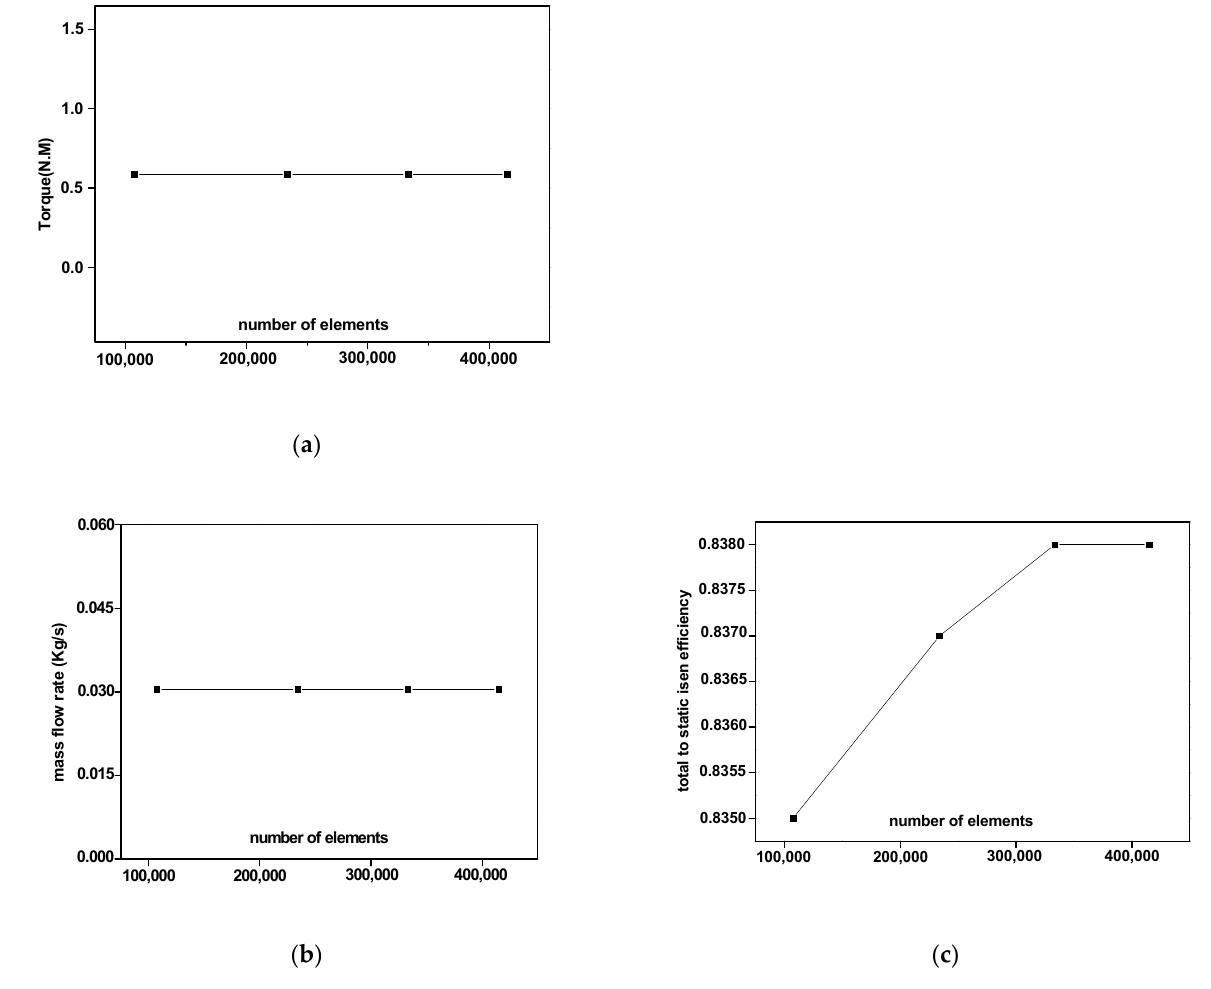
Figure 6. Effect of element number on, torque ( a ), mass flow rate ( b ), and efficiency ( c ).